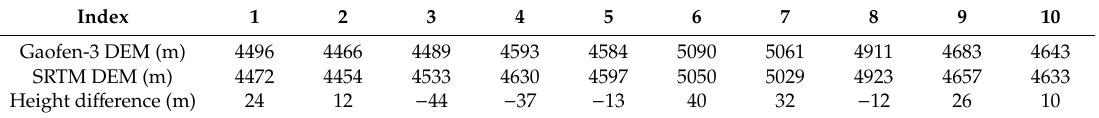
Table 2. Height comparisons of the Gaofen-3 DEM and the SRTM DEM for check points.